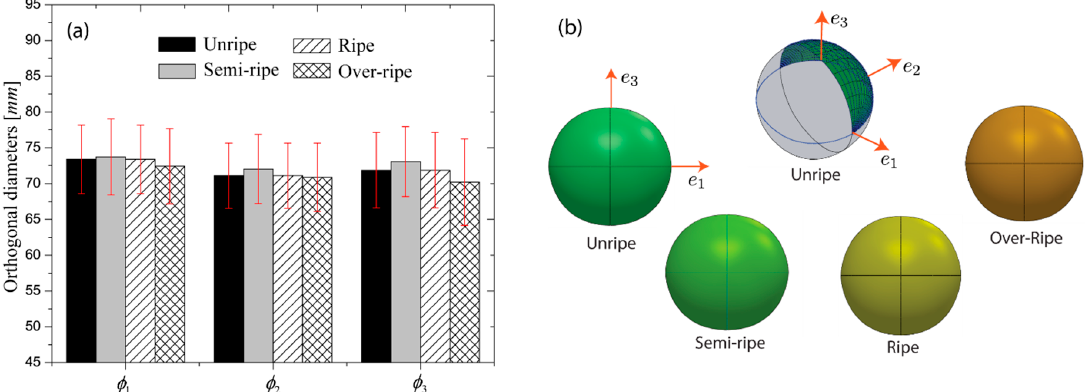
Figure 7. ( a ) Experimental data of orthogonal diameters, the representation of Table 3. ( b ) CAD models generated for unripe, semi-ripe, ripe, and overripe fruits in SOLIDWORKS. Table 3. Orthogonal dimensions for di ff erent ripening